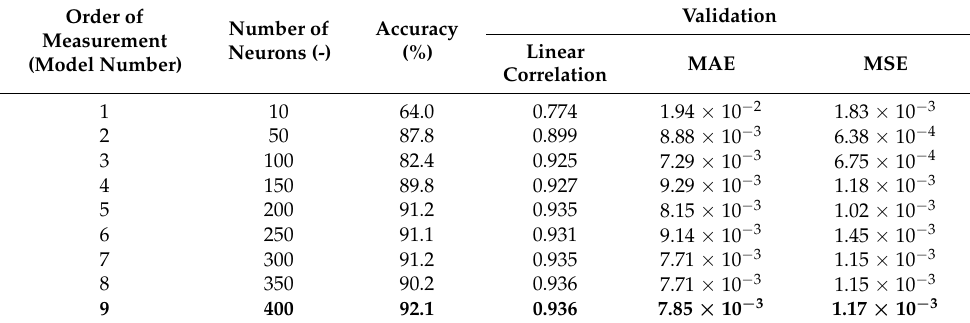
Table 9. The average of the obtained results in the six performed